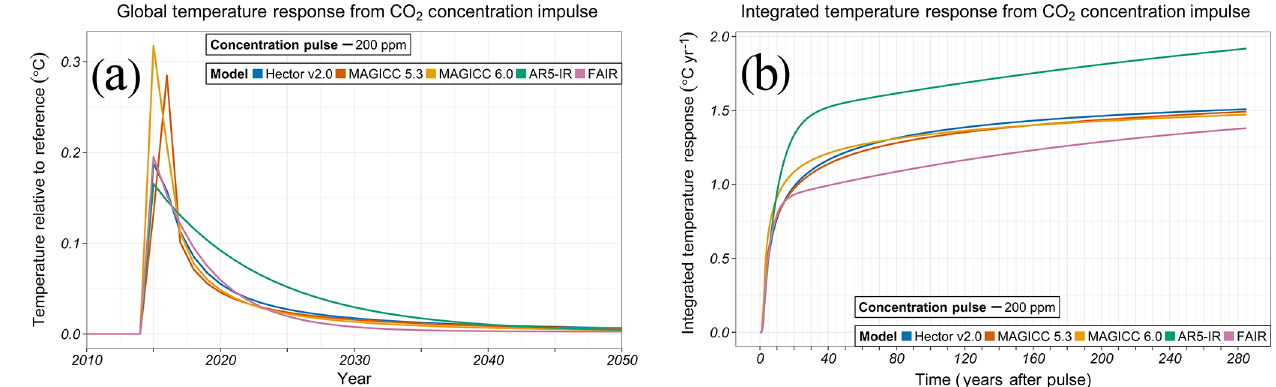
Figure 1. Global mean temperature response (a) and integrated global mean temperature response (b) from a CO 2 concentration perturbation in SCMs (MAGICC 6.0 – yellow, MAGICC 5.3 BC–OC – red, Hector v2.0 – blue, AR5-IR – green, FAIR – pink). The perturbations are conducted in 2015 against the background of the Representative Concentration Pathway (RCP) 4.5 scenario (see Methods). The time- integrated response, analogous to the absolute global temperature potential, is reported as 0–285 years after the perturbation (Sect.